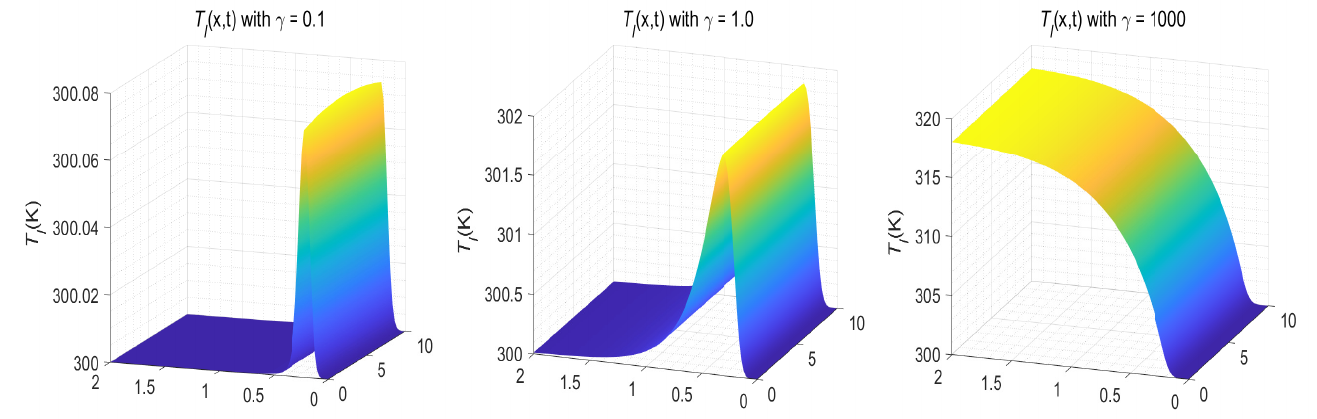
Figure 14. Temperature distributions of T l versus ( x , t ) with various γ when K n = 61.84658, ( α , β ) = ( 0.9,0.9 ) , N = 100, and M = 100 for Example 2.